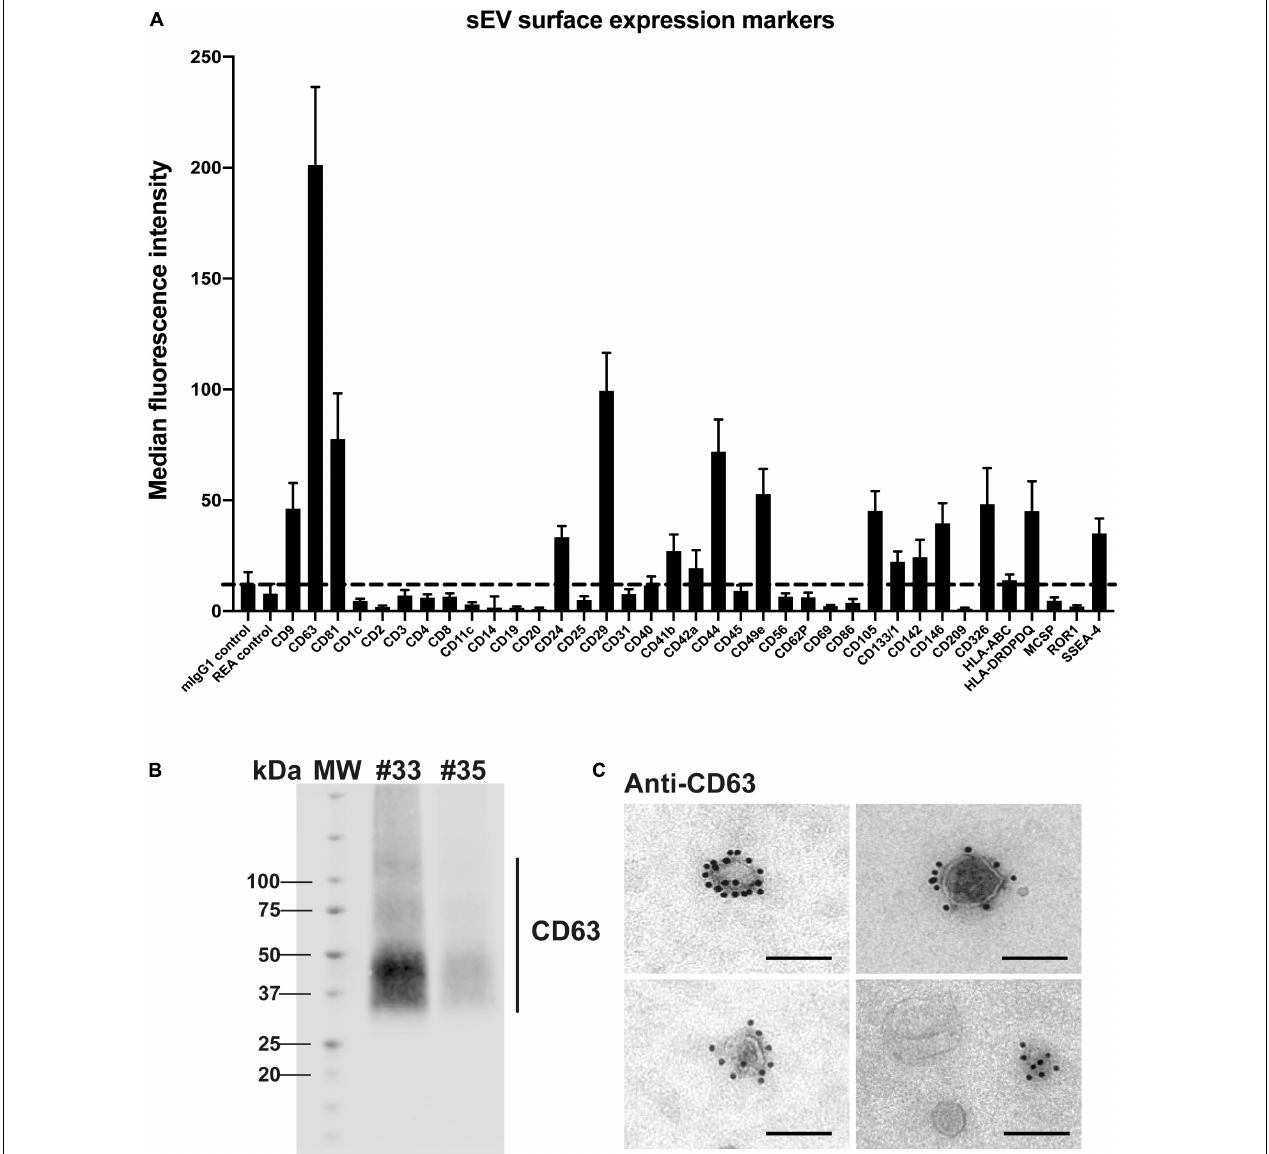
FIGURE 4 | Analysis of placental sEV surface proteins. (A) Surface expression level of several proteins of sEVs, based on the multiplex flow cytometry MACSPlex exosome kit assay. Each bar of the histogram represents the mean ± SEM calculated for 6 independent experiments, expressed in Median Fluorescence Intensity for different sEV markers indicated on the X axis. The dashed line represents the detection limit of the test (defined by the two first controls on the left of the histogram). (B) Representative western blot analysis against CD63 performed on two independent sEV preparations (#33 and #35). CD63 appears as a smear, since the non-reducing conditions of the western blot preserve its rich glycosylated pattern. MW = molecular weight. (C) Placental sEV were immunogold-labeled for CD63, revealed with Protein A-gold particle of 10 nm diameter and observed by TEM. Scale bar = 100 nm ( n = 2).